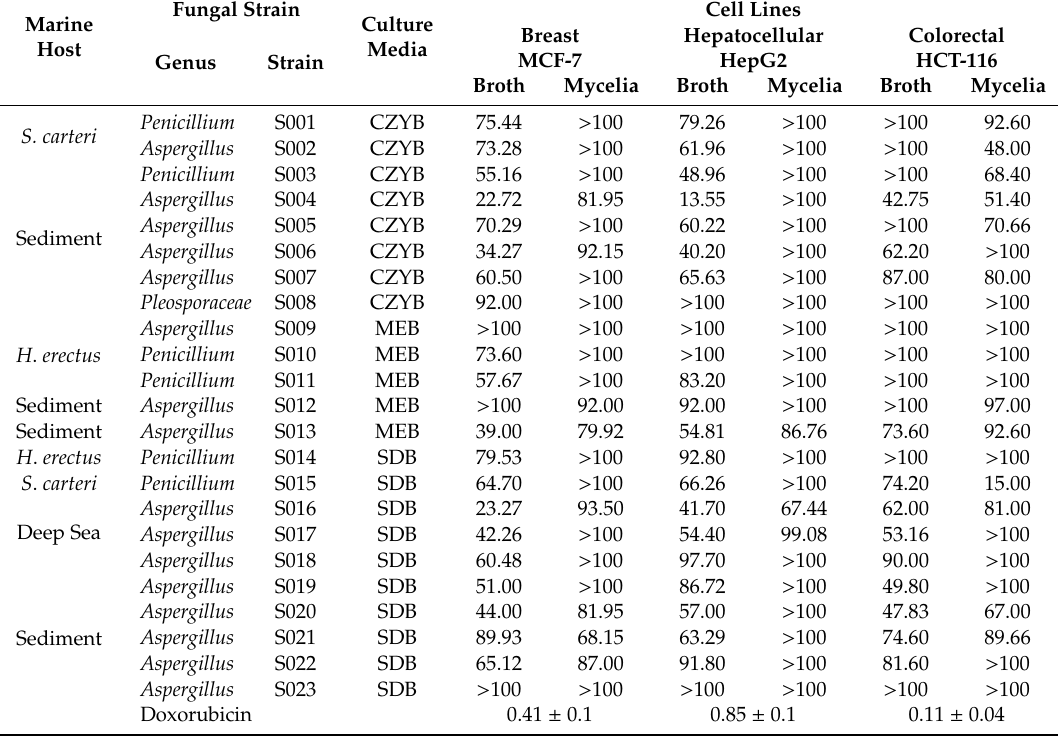
Table 2. In vitro antiproliferative activities (IC 50 , µ g / mL) of isolated fungal strains’ (S001–S023) crude extracts of both fermentation broth and mycelia against human carcinoma cells (MCF-7, HCT-116, and